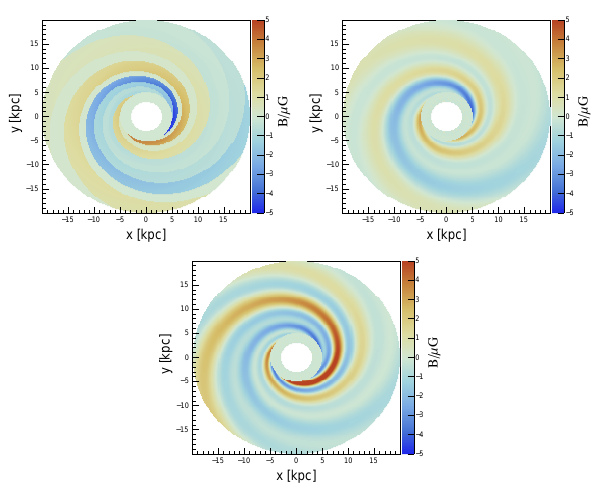
Figure 1. Fits of the coherent disk field. Upper Left: “Wedge”- model of Brown + 07 with fixed pitch angle of α = 11 . 5 ◦ . Up- per Right: Smooth model with three modes ( α = (13 . 4 ± 0 . 7) ◦ ). Lower Middle: Smooth model with four modes ( α = (14 ± 0 . 5) ◦ ). The Sun is located at x = − 8 . 5kpc and y = 0kpc and the mag- netic field strength is shown in color.